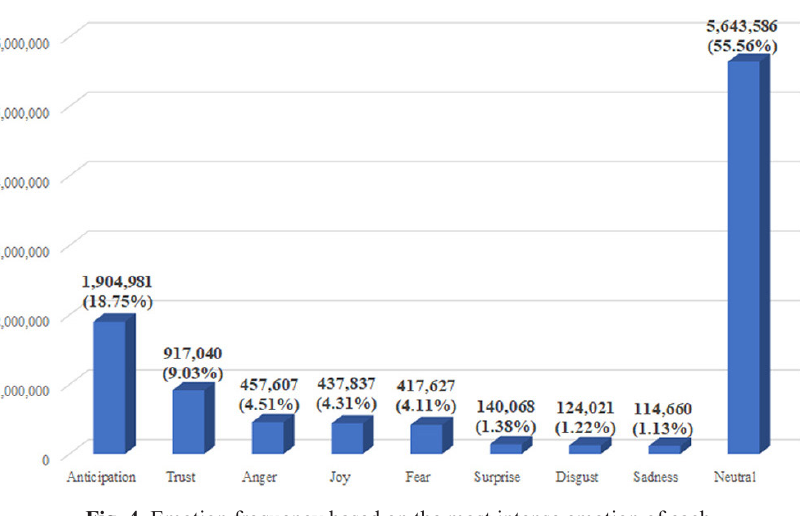
Fig. 4. Emotion frequency based on the most intense emotion of